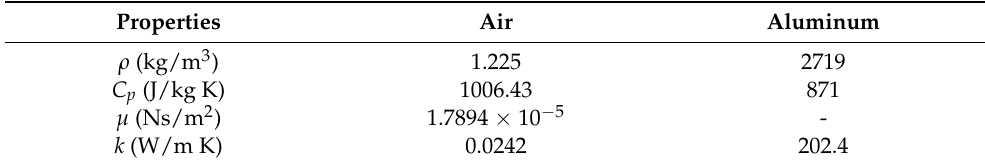
Table 3. Values of operating parameters for numerical analysis.